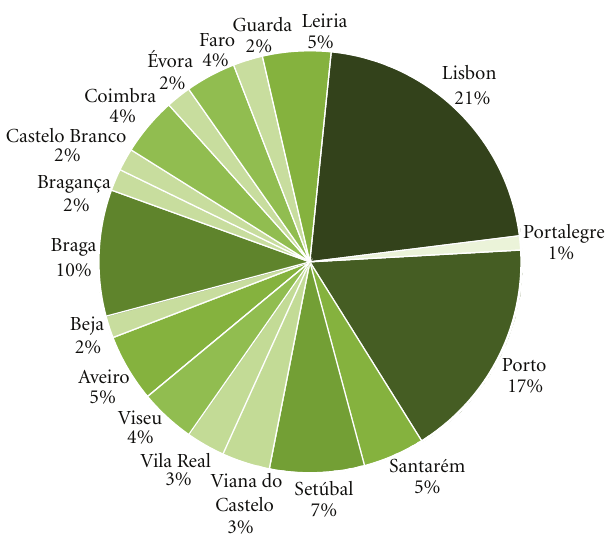
Figure 3: Distribution of demographic data by district in